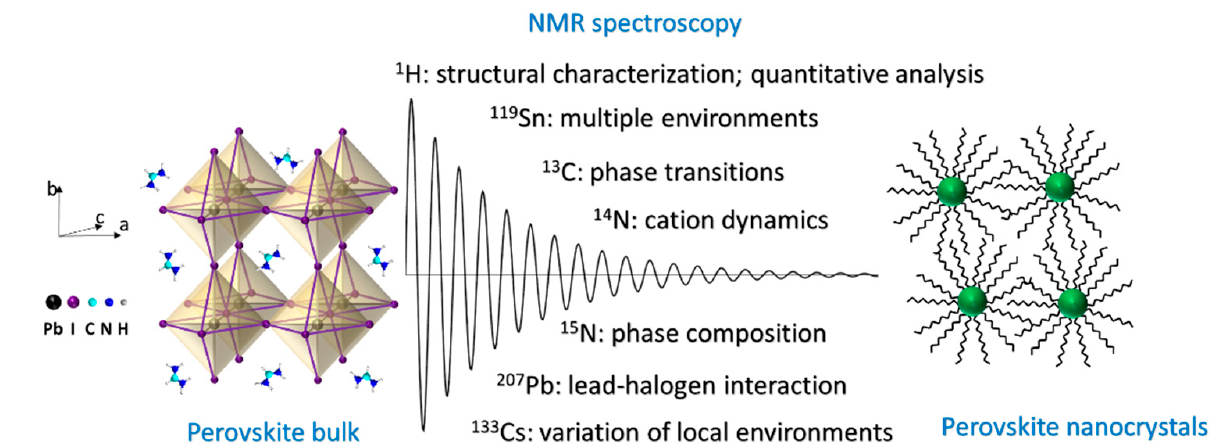
Scheme 1. From left to right: sketch of the formamidinium perovskite structure in its cubic crystal phase; NMR tools for perovskite characterization; perovskite nanocrystals with the inorganic core and organic coordinating